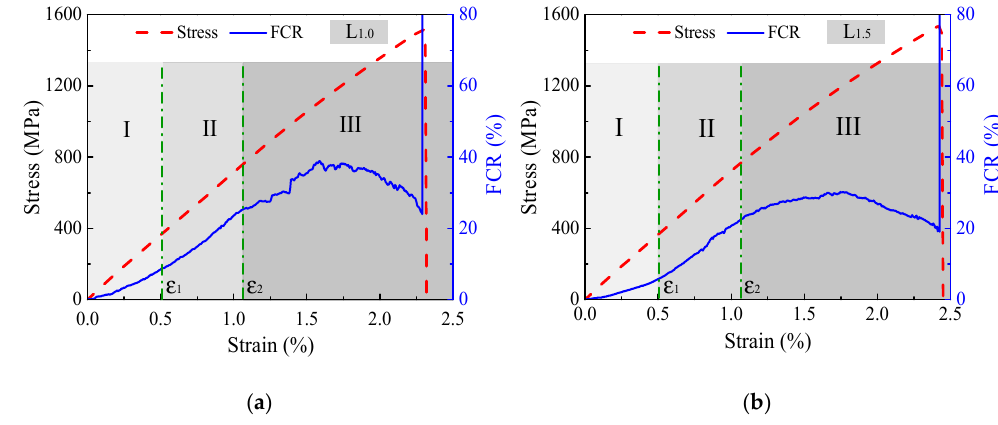
Figure 7. In situ damage monitoring of ( a ) L 1.0 and ( b ) L 1.5 under monotonic tensile loading. FCR, fractional change in electrical resistivity.